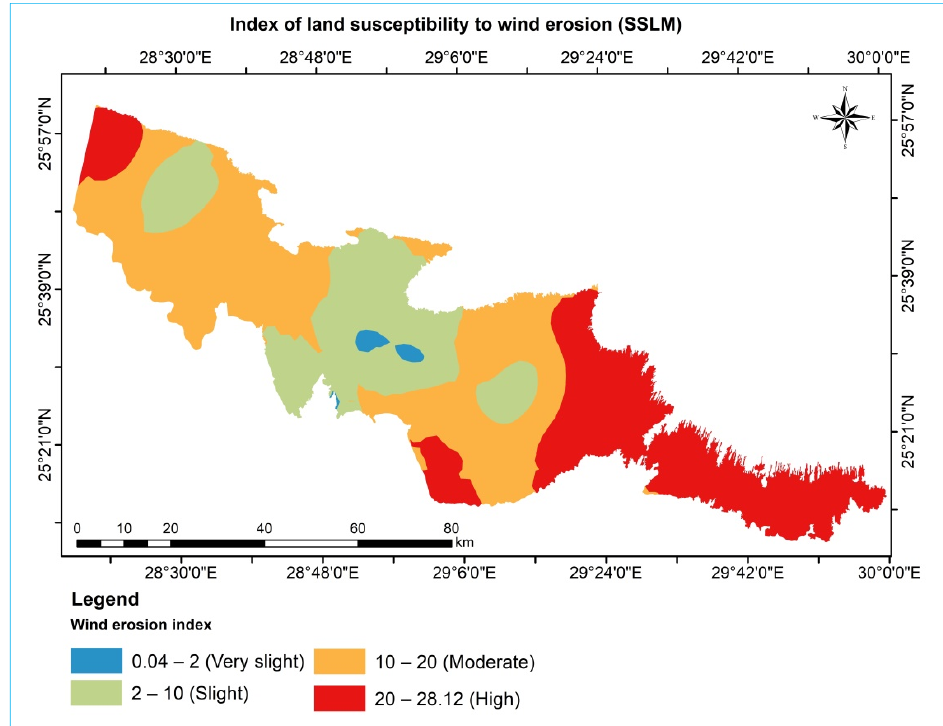
Figure 14. Spatial distribution map of wind erosion indexes and classes according to the ILSWE model. Table 13. Wind erosion indexes and classes according to the ILSWE model and the proposed model (SSLM).